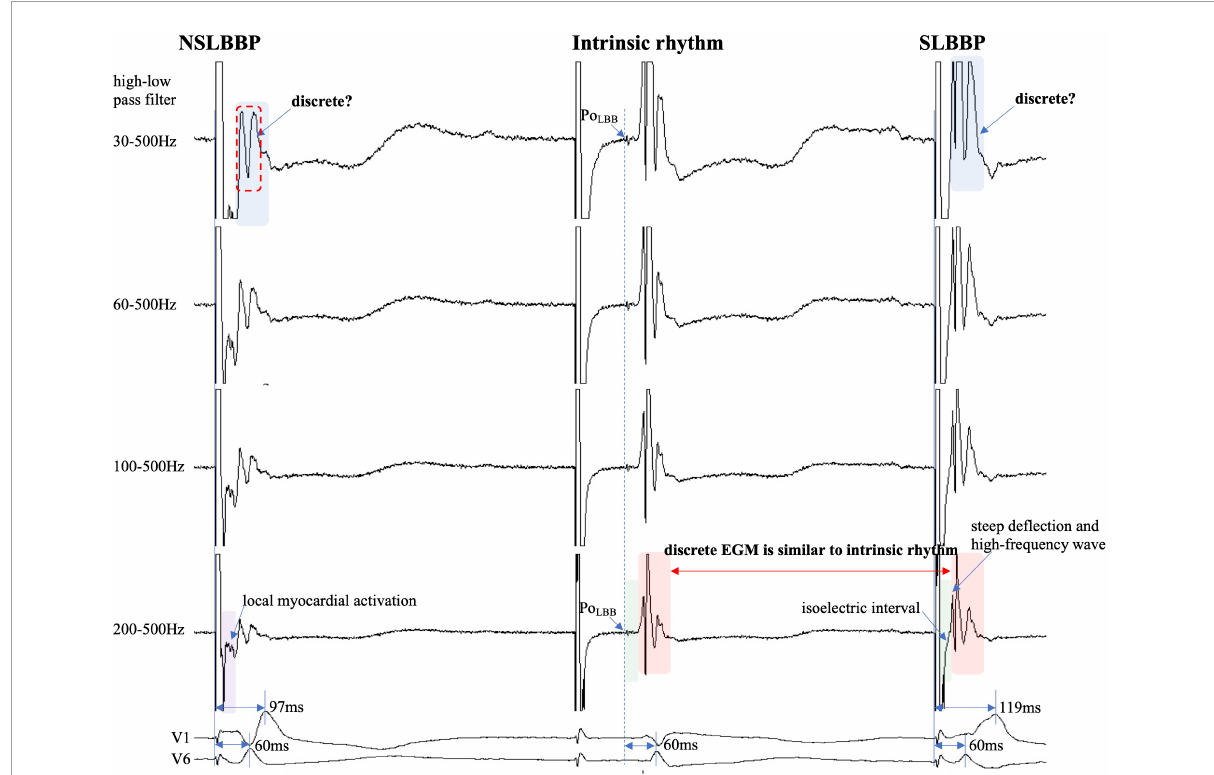
FIGURE5 Discrete ventricular components cannot be accurately identified because the entire EGM morphology cannot be visualized (blue rectangle). Discrete local ventricular EGM morphology resembles ventricular EGM morphology of intrinsic rhythm (red rectangle). The isoelectric interval of paced rhythm and native rhythm (green rectangle). Changes in high-pass filter settings do not affect the identification of Po LBB (blue dashed line). Isoelectric interval does not appear during local myocardial activation (purple rectangle). Abbreviations as in Figure 1